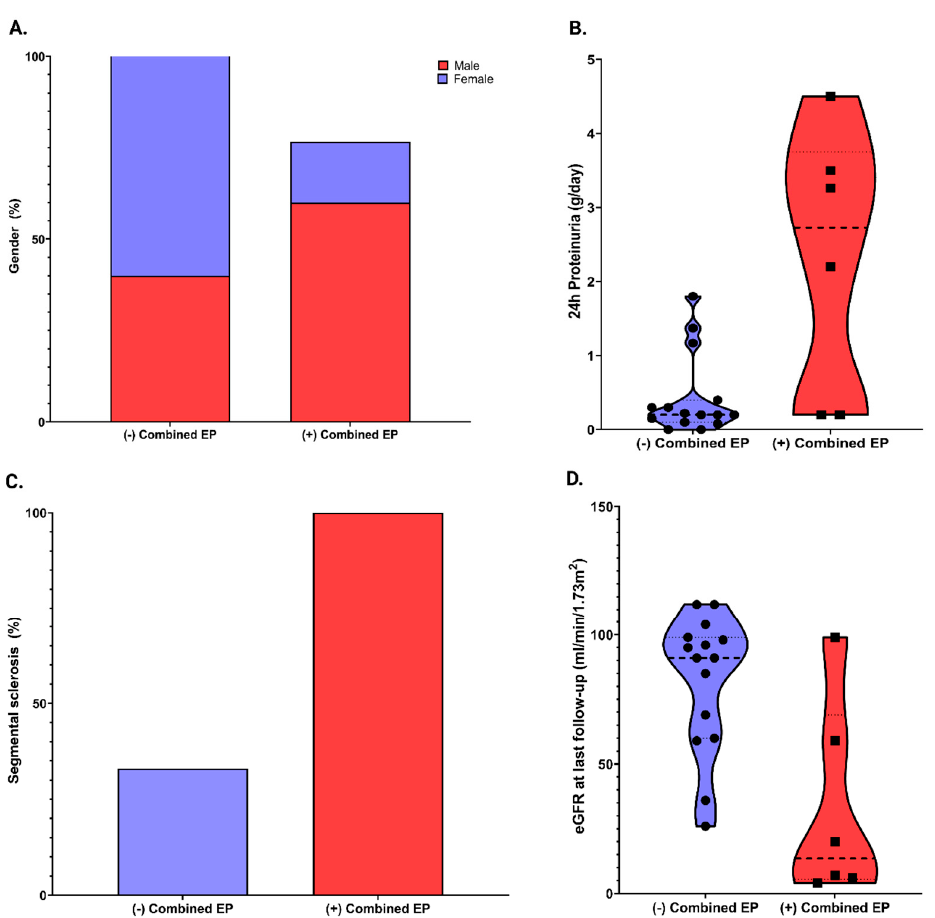
Figure 2. Variables associated with combined endpoint (EP). ( A ) Gender ( p = 0.06); ( B ) Baseline 24 h proteinuria ( p = 0.02); ( C ) Segmental sclerosis ( p = 0.009); ( D ) eGFR at last follow-up ( p = 0.003).